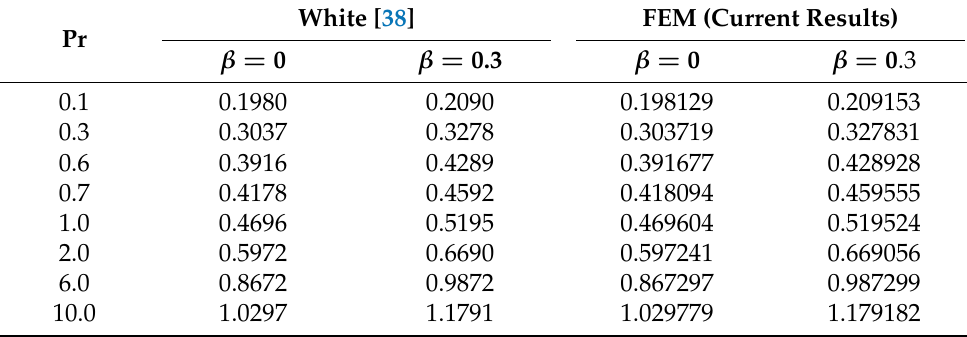
Table 4. Numerical values of Nusselt number − Re 1/2 Nu for different values of Prantdl number Pr and wedge angle parameter β when (cid:101) , We, Nt, Nb, f w , Sc, and Ha are fixed